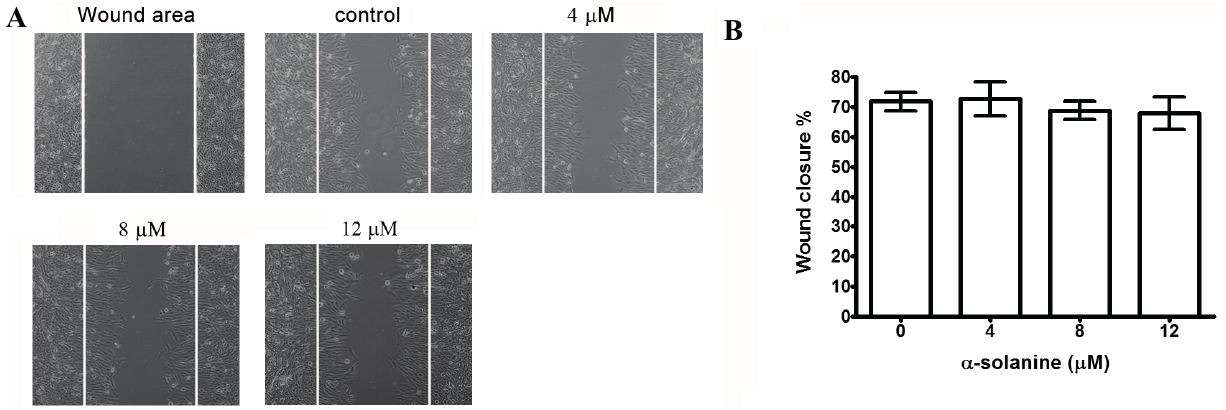
indicating that α -solanine markedly inhibits invasion of PC-3 cells and that such inhibition is not due to any cytotoxicity. Figure 2. Effect of α -solanine on migration of PC-3 cell. ( A ) Cell monolayers were scraped by a sterile micropipette tip and the cells were treated with various concentrations of α -solanine for 24 h. Cells migrated to the wounded region were photographed (100× magnification). ( B ) The wound area of the cell cultures were quantified in four fields in each treatment, and data were calculated from three independent experiments. Data are presented as mean ± S.D. of three independent experiments.